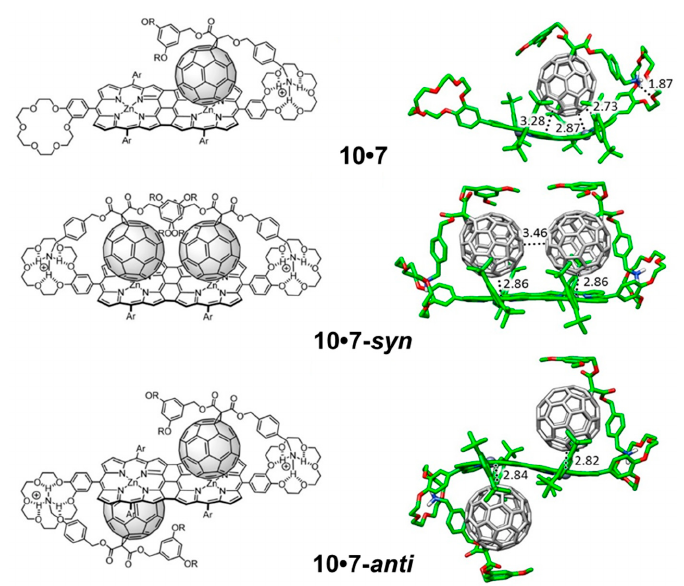
Figure 14. Chemical structure (left) and minimum-energy geometry calculated at the B97-D3/(6-31G**+LANL2DZ) level (right) for the supramolecular assembly of ditopic host 10 with one and two molecules of guest 7 . Except for C 60 carbon atoms depicted in grey, the following color code is used: carbon in green, nitrogen in blue, oxygen in red and hydrogen in white. Adapted with permission from [90]. Copyright 2014 American Chemical Society.